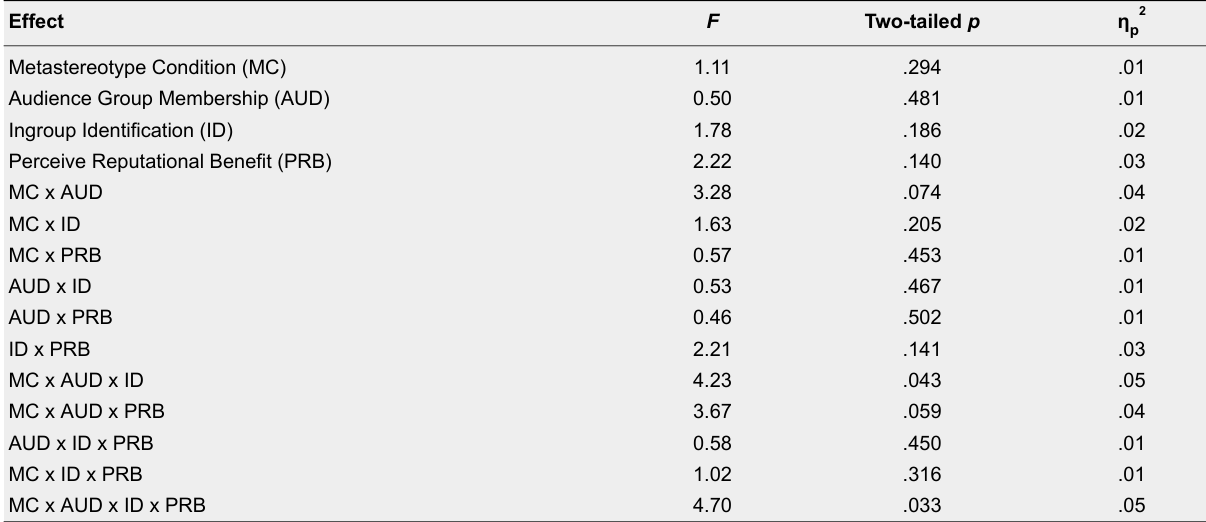
ANOVA Model Results for the Effect of Metastereotype Condition, Audience Group membership, Ingroup Identification, and Reputational Benefit on Expressed Intentions to Help the